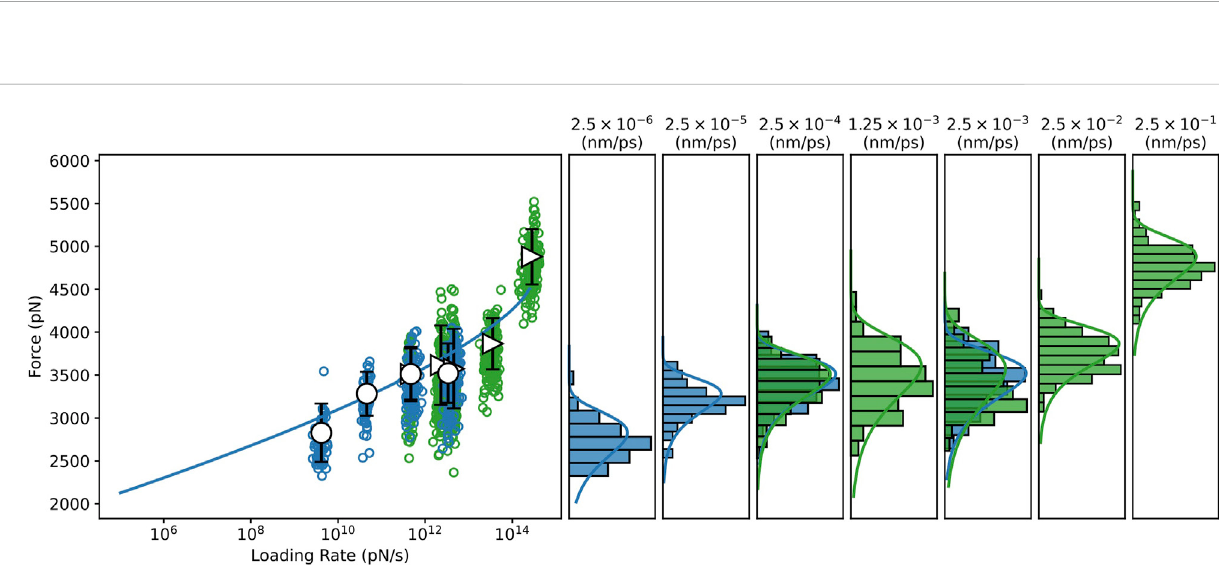
FIGURE 3 Dynamic Force spectrum for the Bbp: Fg α complex combining data from all-atom and coarse-grained SMD simulations. All-atom, and Coarse-grained steered molecular dynamics simulations (CG-SMD and aa-SMD) were performed at different velocities: 2.5×10 − 6 to 2.5×10 − 3 nm/ps (blue) and 2.5×10 − 4 to 2.5×10 − 3 nm/ps (green), respectively. A Dudko-Hummer-Szabo Dudko et al. (2006) (DHS) fi t was performed through the SMD dataset predicting Δ x = 7.489×10 − 2 nm , k 0 off = 2.596×10 − 12 s − 1 , Δ G = 2.293×10 2 k B T